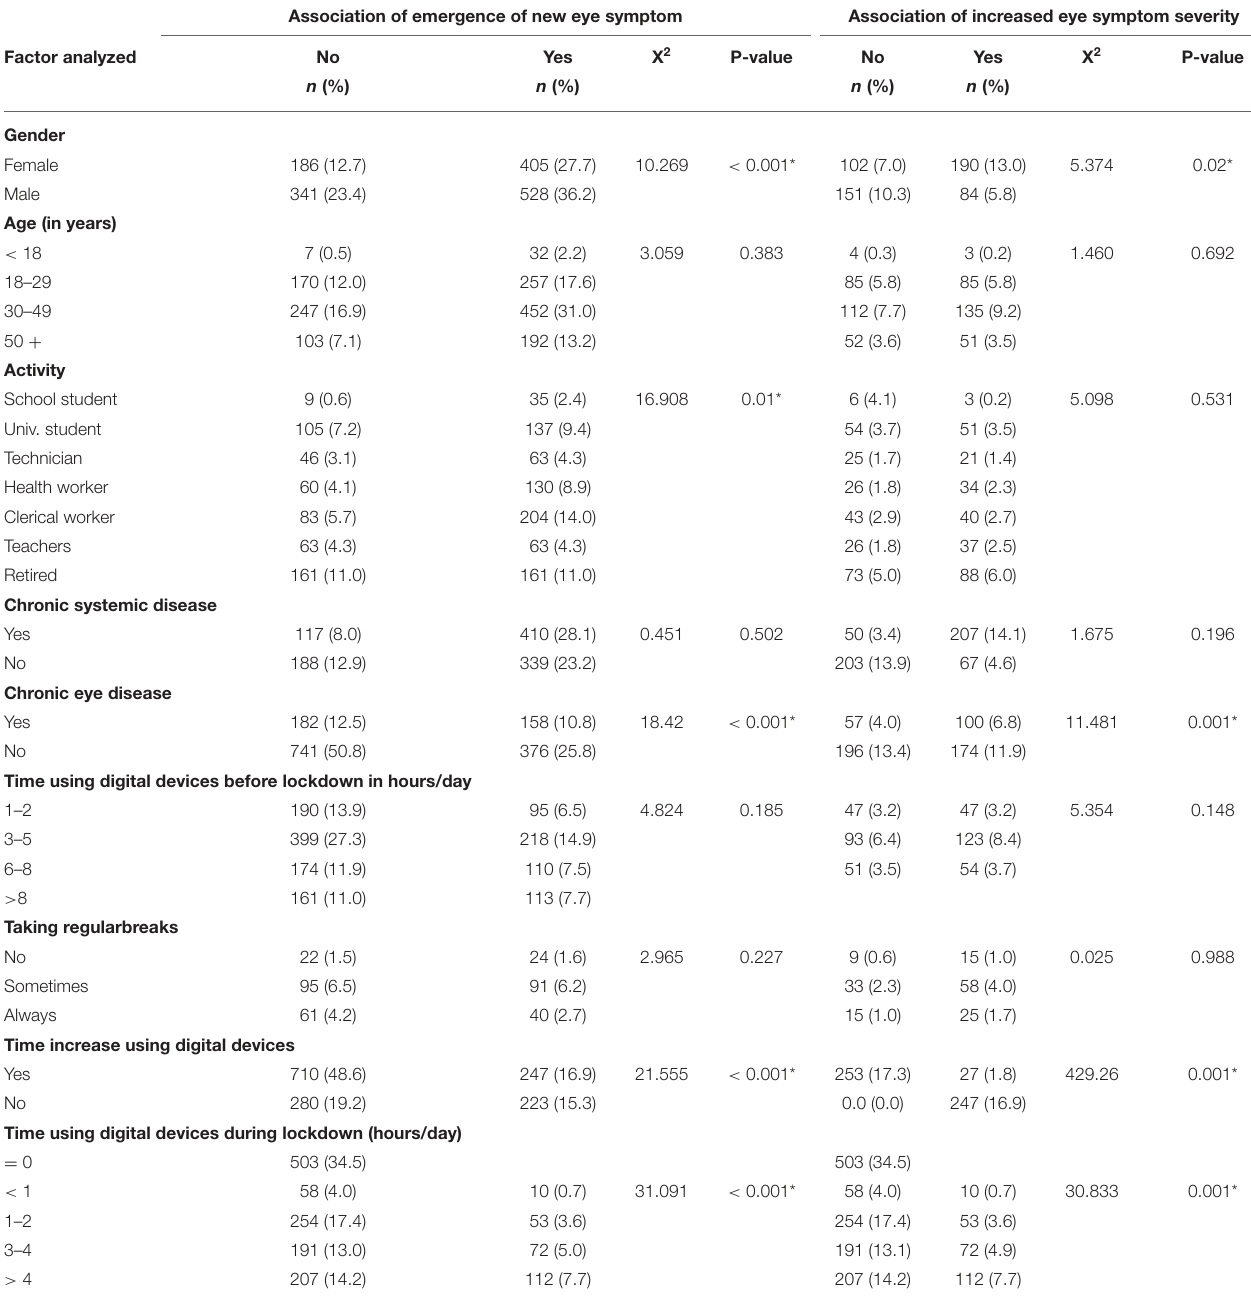
TABLE 3 | Sample characteristic factors associations with emergence of new DES symptoms and increased severity of existed symptoms. Association of emergence of new eye symptom Association of increased eye symptom